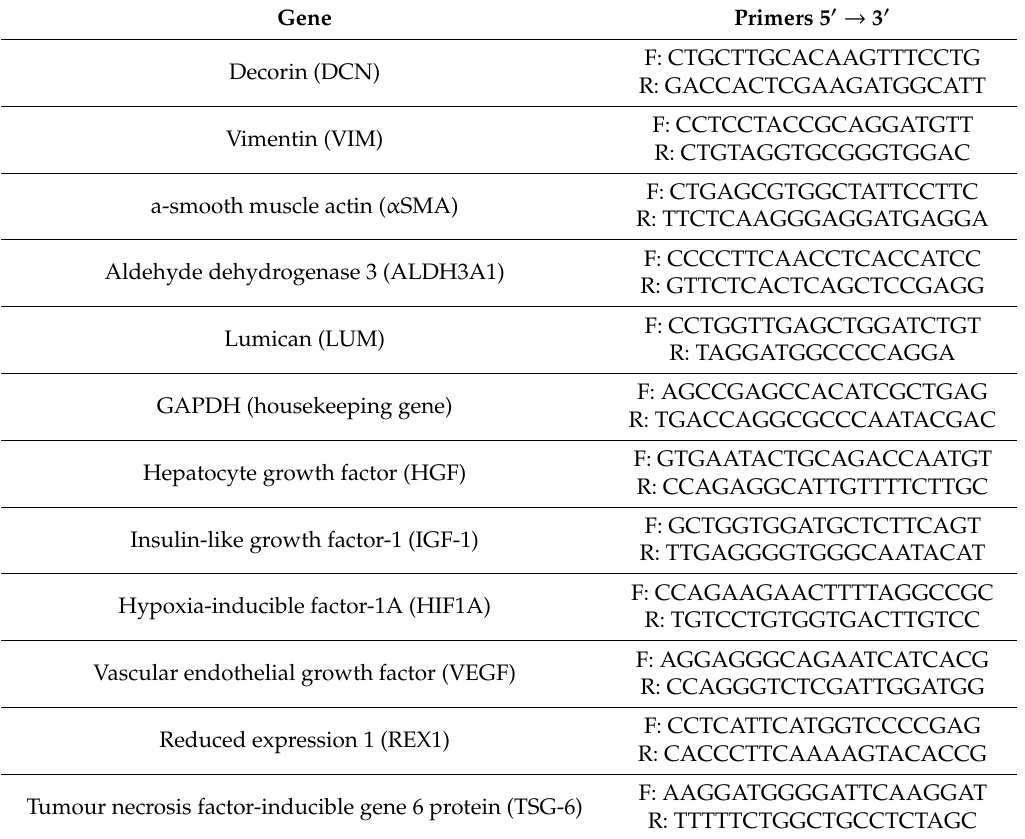
Description of primers used in real-time PCR for corneal stromal keratocytes and adipose-derived stem cells gene expression